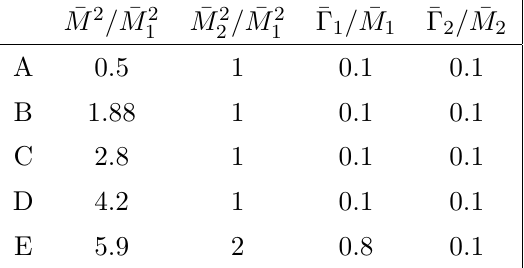
Table 1. Mass and width settings relevant to illustrative studies of the trajectory method. For all of these cases we also set (cid:22)(cid:0) = (cid:22) M . The trajectories we consider are dimensionless, hence there is no need to specify a reference mass scale.